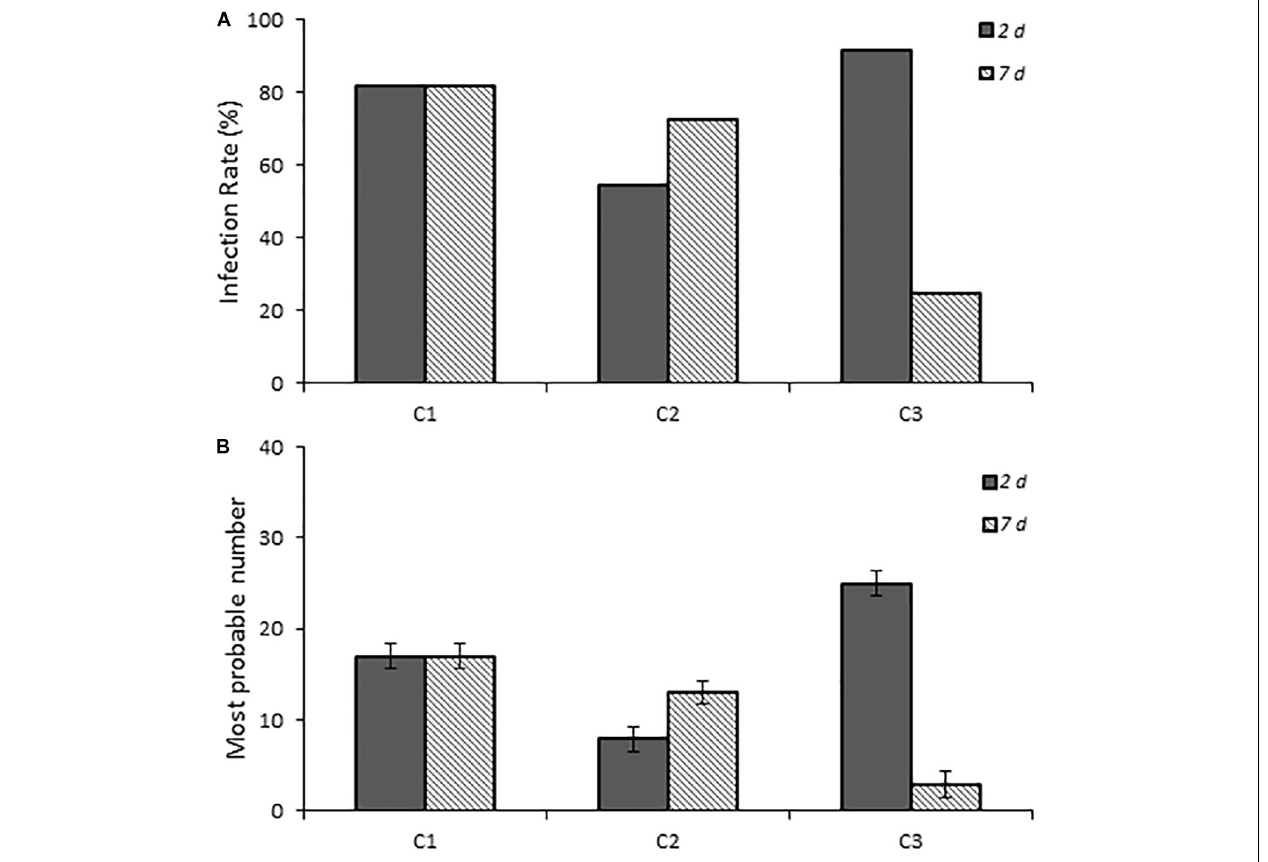
FIGURE 3 | Infection rates and fecal burden levels of Campylobacter from chicks infected with clinical isolates of Campylobacter spp. (A) shows chicks infected with dose B Campylobacter spp. Percent infected was determined by dividing the number of infected chicks by the total number of chicks inoculated with the various Campylobacter species. Chicks were considered infected if fecal samples collected at the various times were positive for Campylobacter spp. as determined by using the passive-filter plating as described in the section “Materials and Methods.” (B) shows the fecal burden as measured by using the most probable number